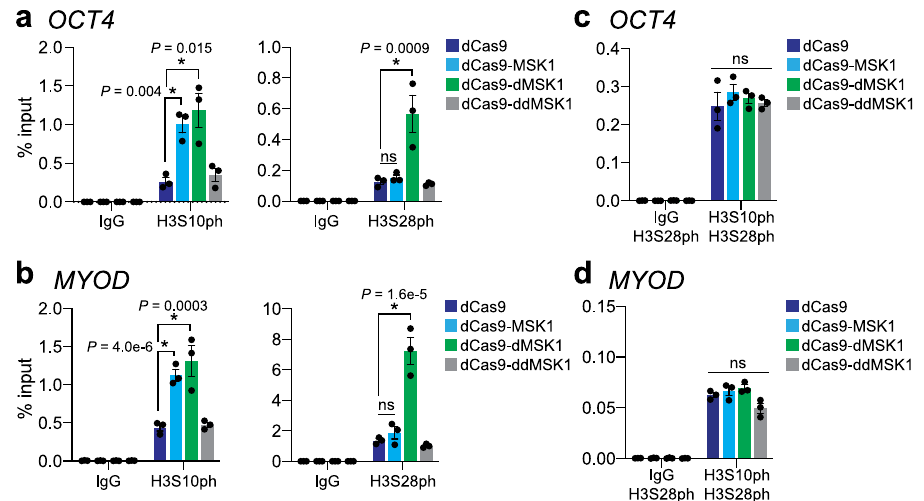
Fig. 4 dCas9-dMSK1 induces target gene activation via H3S28ph. a , b ChIP-qPCR enrichment for H3S10ph and H3S28ph, at the OCT4 (panel a ) or MYOD (panel b ) promoters 72 h post-transfection of dCas9 or indicated dCas9-fusion protein and corresponding gRNAs. c , d Re-ChIP-qPCR enrichment for H3S10ph and H3S28ph at OCT4 (panel c ) or MYOD (panel d ) promoters 72 h post-transfection of dCas9 or indicated dCas9-fusion protein and corresponding gRNAs. Two-sided t -test, * P < 0.05; n = 3 independent experiments for all panels; error bars, s.e.m.; ns, not signi fi cant. Source data are available in the Source data fi le.